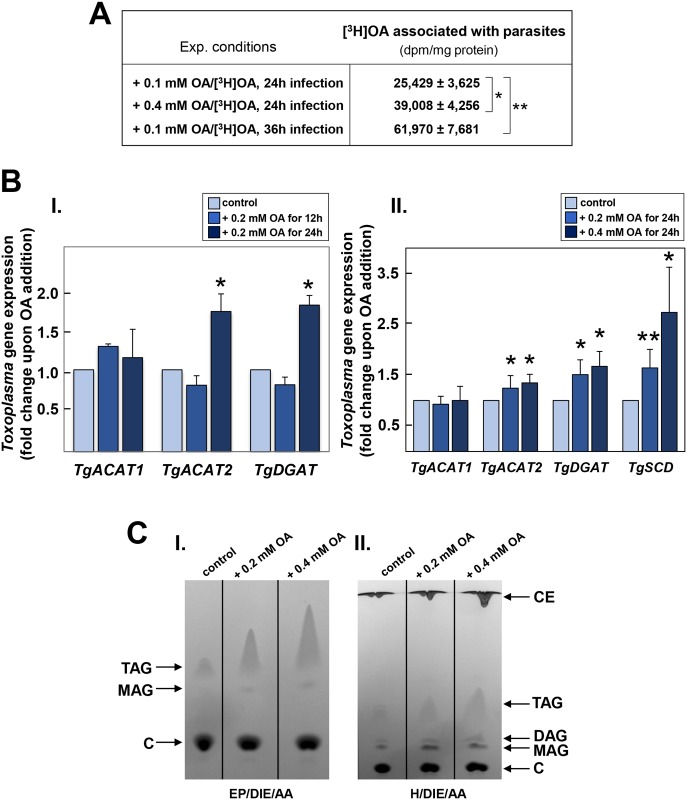
Influence of excess oleate on parasite neutral lipid synthesis.A. Uptake assays of radioactive OA by Toxoplasma. HFF were preincubated with 0.1 or 0.4 mM OA containing [3H]OA for 24 h, thoroughly washed and infected with Toxoplasma for 24 h or 36 h before chemically inducing parasite egress. Parasites were collected and purified to monitor their radioactivity by counting. Data of [3H]OA associated with the parasites expressed in dpm/mg cell protein, are means ± SD of 3 independent assays made in triplicates. *p <0.05; **p <0.001. B. Comparison of Toxoplasma ACAT and DGAT gene expression under conditions of excess OA or without added OA (control). Real-time PCR analysis of TgACAT1, TgACAT2, TgDGAT and TgSDC transcripts in parasites infecting cells exposed to 0.2 mM OA for 12 h or 24 h (panel I), or to 0.2 or 0.4 mM for 24 h (panel II). Data are means ± SD of 3 independent assays performed in triplicates. Transcripts levels of TgACAT2 and TgDGAT were significantly increased in the presence of excess OA compared to control conditions in the absence of OA (*p <0.004; **p <0.0001). C. TLC analysis of neutral lipid fractions of cellular lipid extracts from intracellular Toxoplasma exposed to excess OA. Neutral lipids were separated on plates using as solvent EP/DIE/AA (panel I) to resolve TAG and MAG, or H/DIE/AA (panel II) to separate CE and DAG. CE and species of acylglycerols were more abundantly produced under conditions of excess OA vs. no OA added.